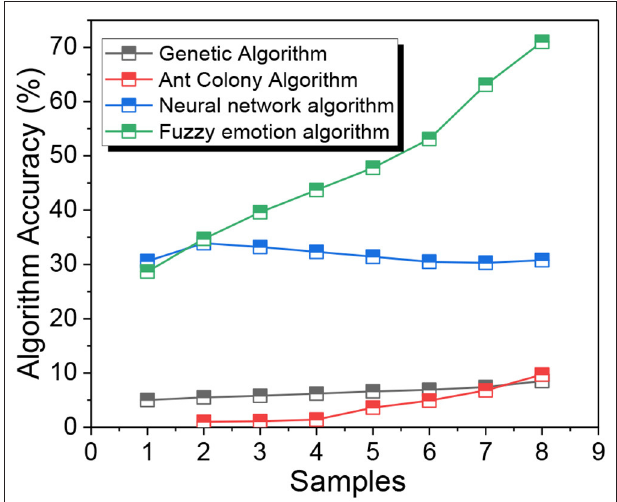
FIGURE 5 | Comparison of accuracy among different